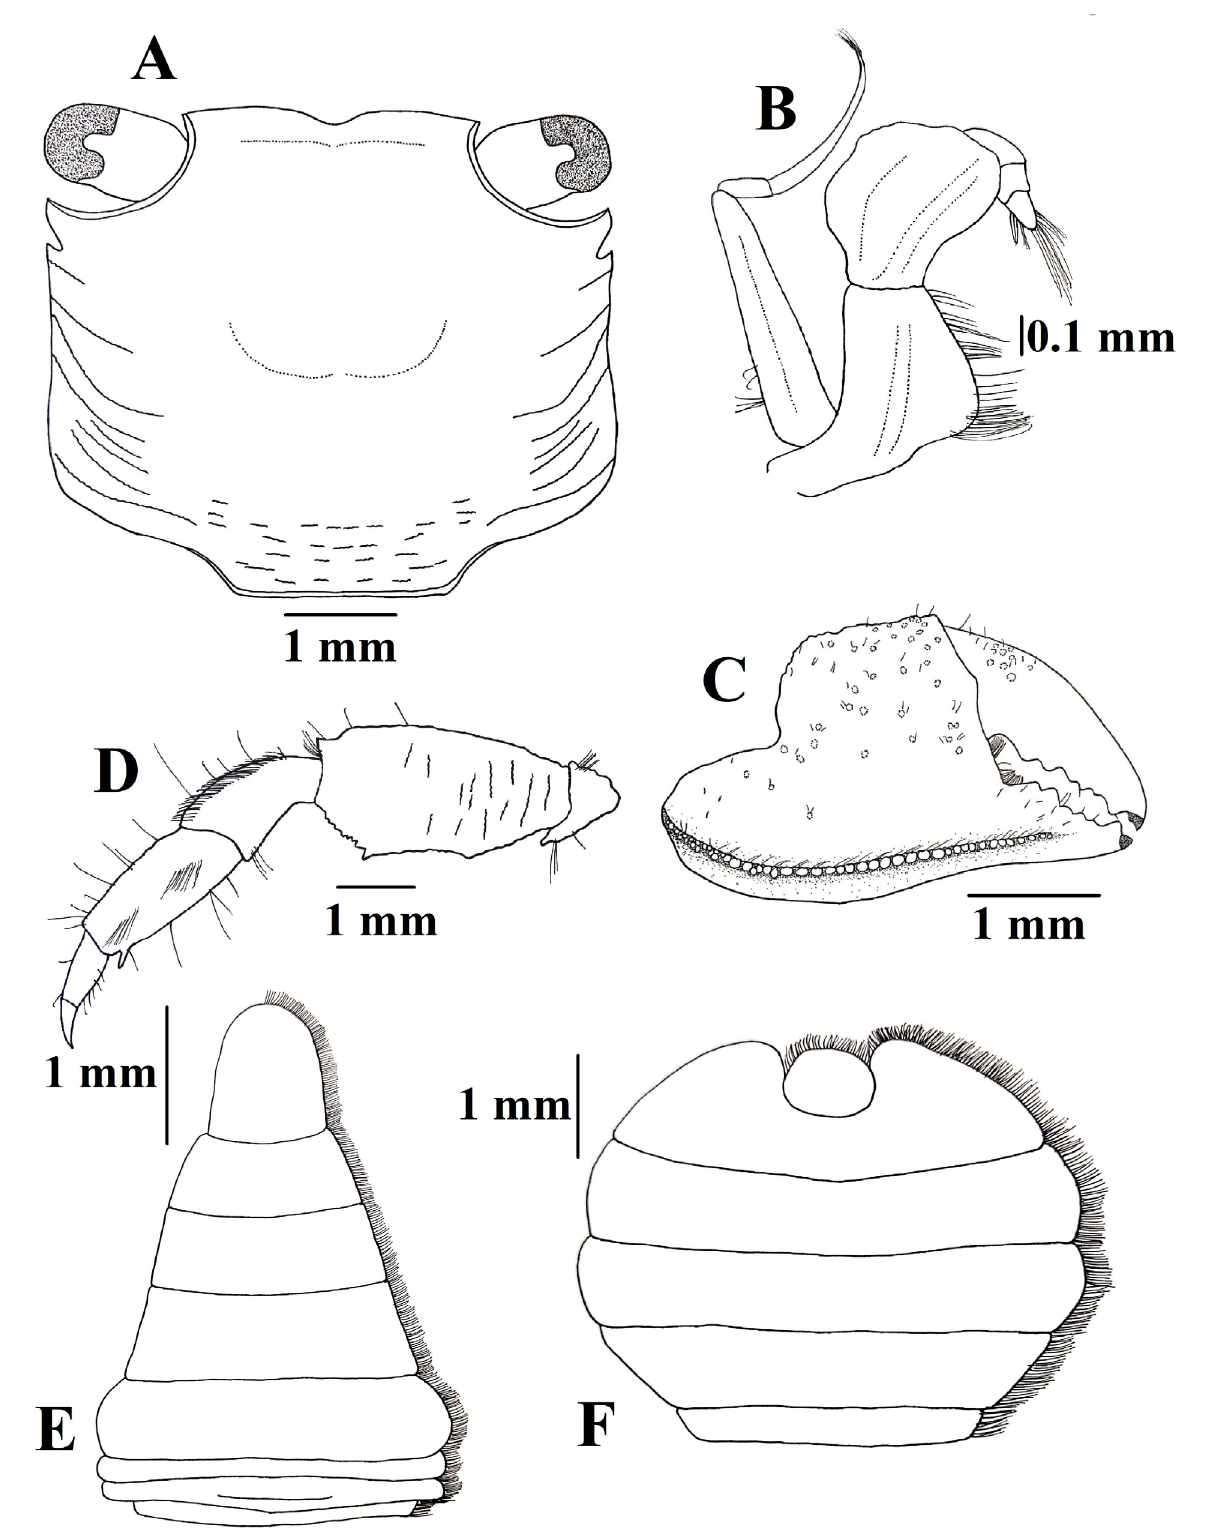
Figure 4. Nanosesarma minutum (De Man, 1887). A – E , Male, (LFSC.ZRC-186) (CL: 4.8 mm; CW: 5.9 mm), Chapora Estuary, Goa, India; F , female (LFSC.ZRC-186) (CL: 4.8 mm; CW: 6.1 mm), Chapora Estuary, Goa, India. ( A ) Carapace; ( B ) right third maxilliped; ( C ) palm of right cheliped (outer face); ( D ) left P5 (dorsal view); ( E ) male pleon; ( F ) female